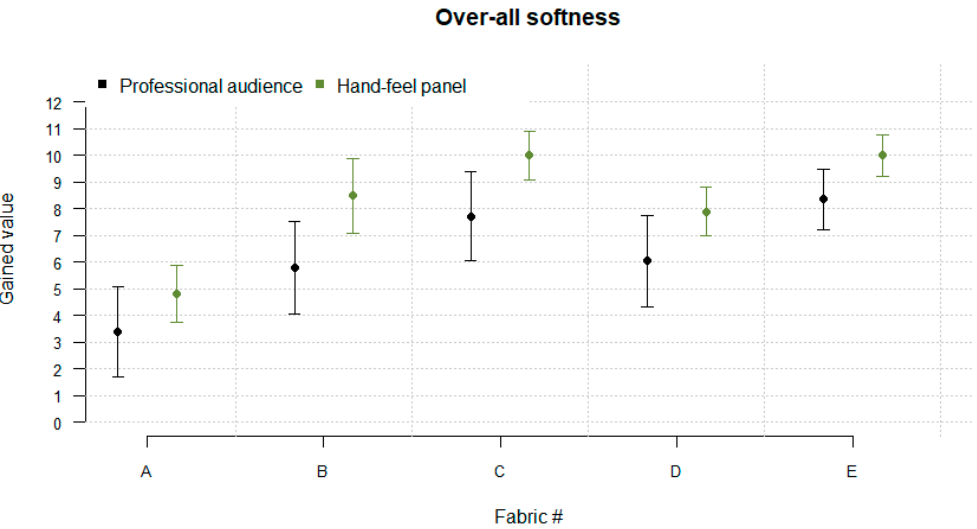
Figure 7. Scaling of fabrics by the professional audience (consumers) and hand feel